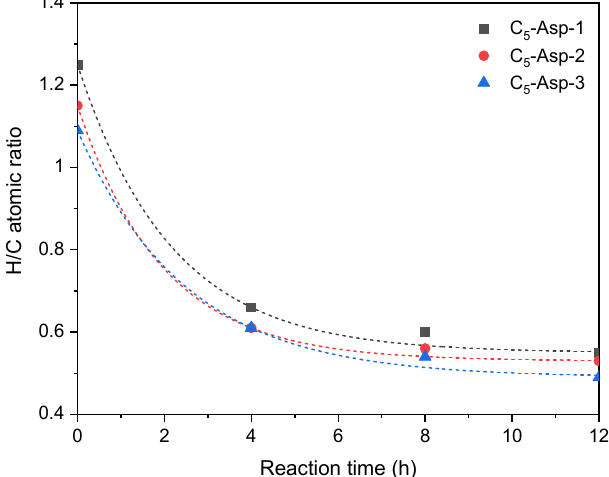
Figure 8. H / C atomic ratio of coke obtained from catalytic hydrocracking of asphaltene subfractions in the semi-batch system. Reaction conditions: T = 410 °C, P H2 = 110 bar, and 1000 wppm of Mo from Mo-octoate.